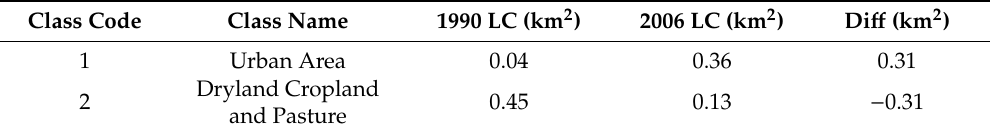
Table 5. LCLU changes between 1990 and 2006 in the second sub-basin.